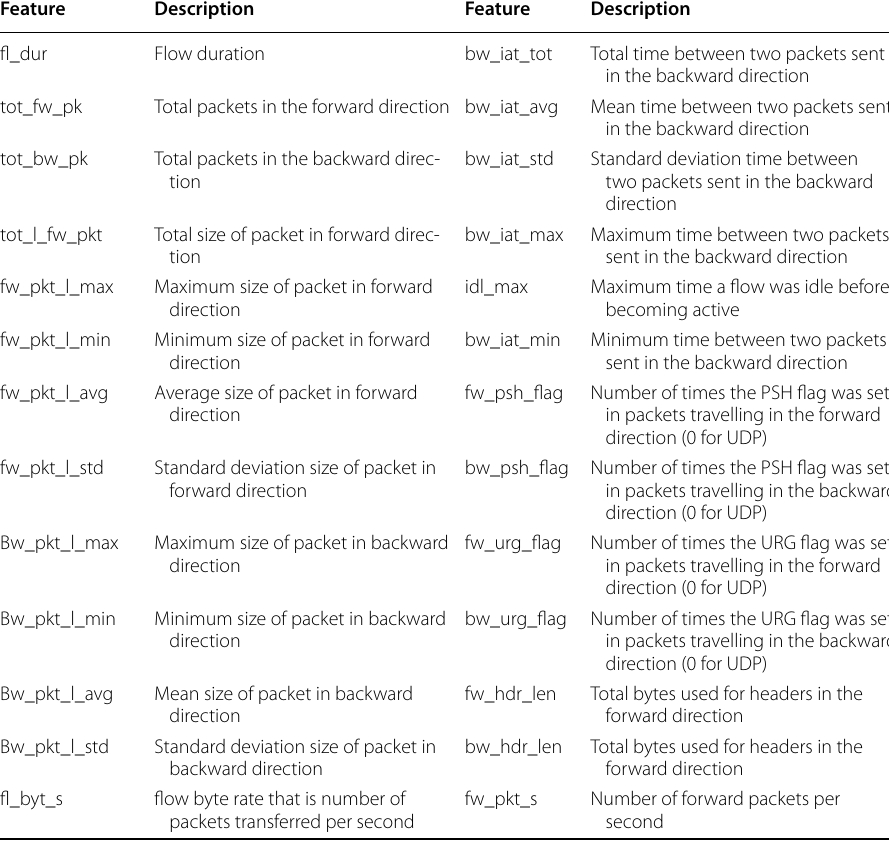
Table 17 List of features in the CIC-IDS 2018 Dataset